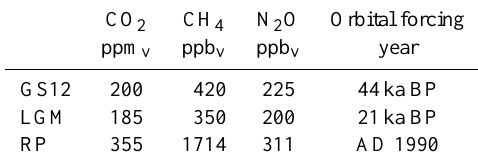
Table 1. Atmospheric GHG concentrations and orbital forcing for the GS12 simulation as compared to the LGM and RP simulations (Spahni et al., 2005; L¨uthi et al., 2008; Berger,